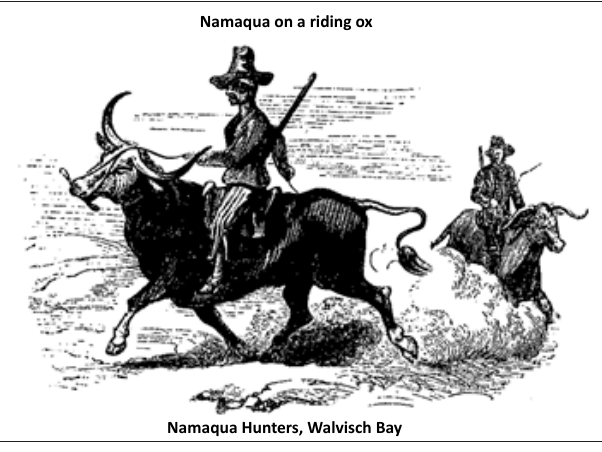
FIGURE 1: Riding oxen in 19th century